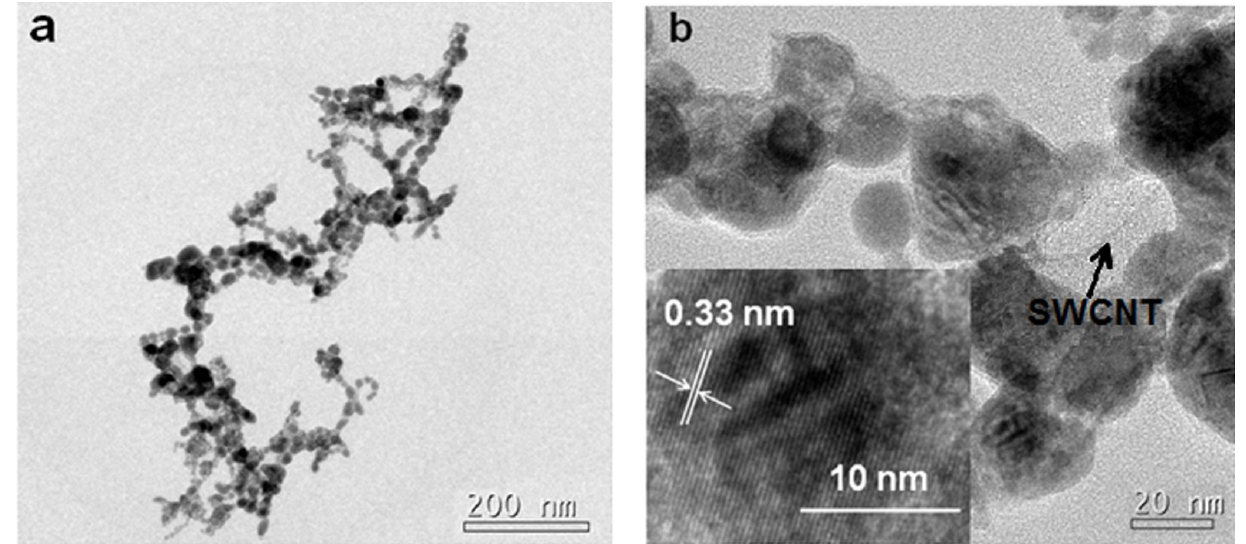
Figure 3. TEM images ( a ) and its high magnification ( b ) of PAA/SnO nanocomposites. Inset of ( b ) shows the (110) planes of SnO